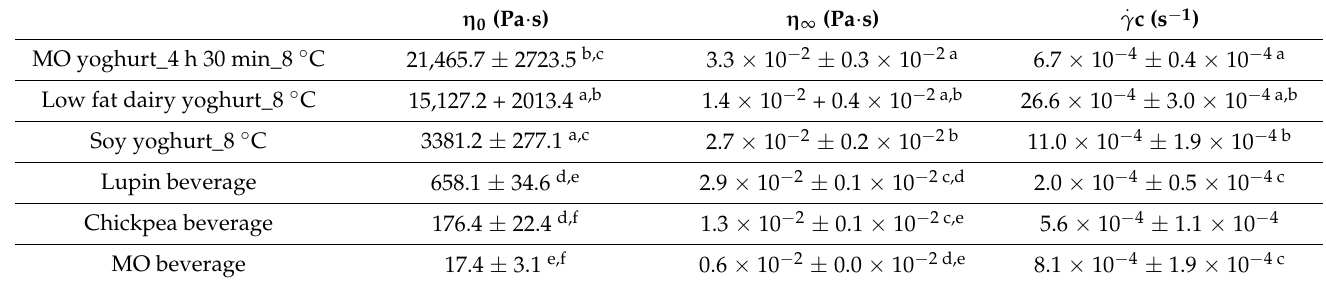
Table 5. The parameters obtained after fitting the flow curves to the Carreau model for all of the beverages and yoghurts are shown ( η 0 , zero-shear viscosity; η ∞ , infinite-shear viscosity; and critical shear rate). Values are represented as mean ± standard deviation ( n = 3). Same letters in samples per parameter, evidence significant differences between them ( p <